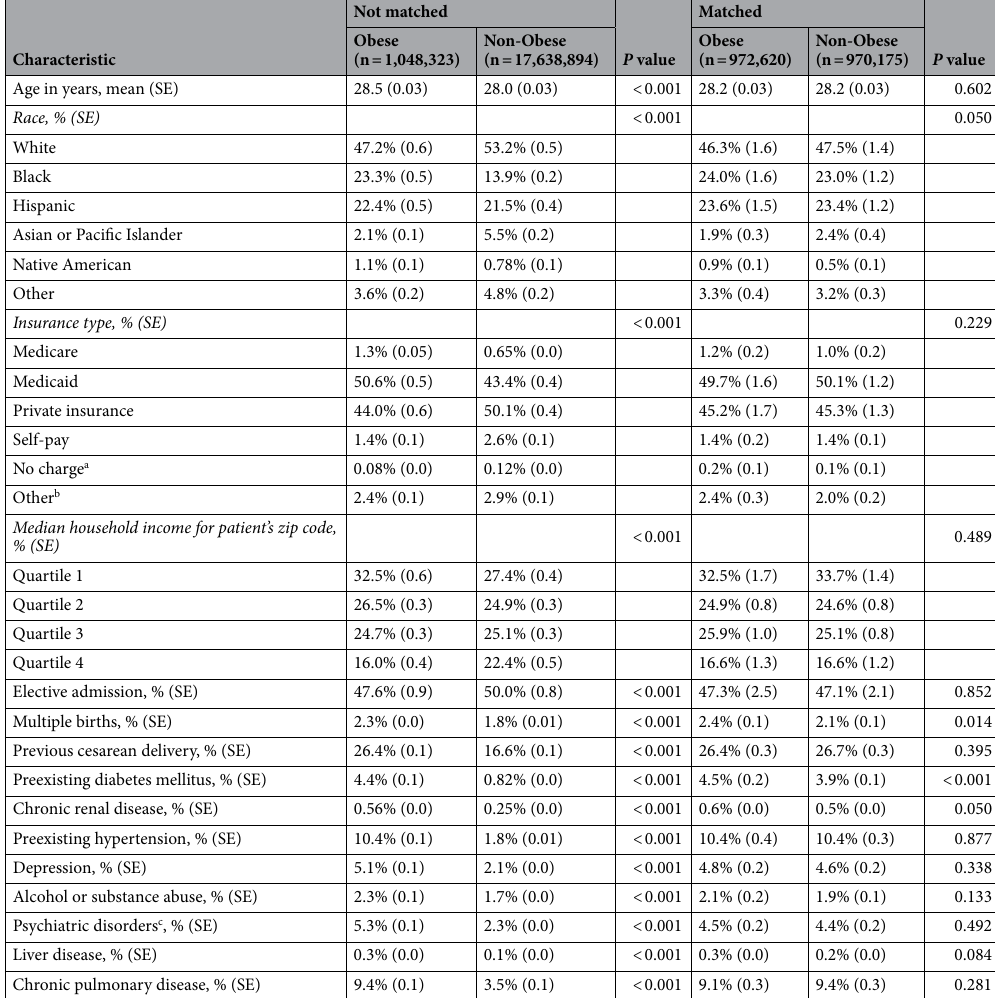
Table 1. Baseline clinical characteristics of obese and non-obese pregnant women. a Care provided as charity, courtesy, or free of charge. b This category includes Worker’s Compensation, the Civilian Health and Medical Program of the Uniformed Services, the Civilian Health and Medical Program of the Department of Veterans Affairs, Title V, and other government programs. c Includes anxiety, adjustment, eating, mood, personality, and psychotic